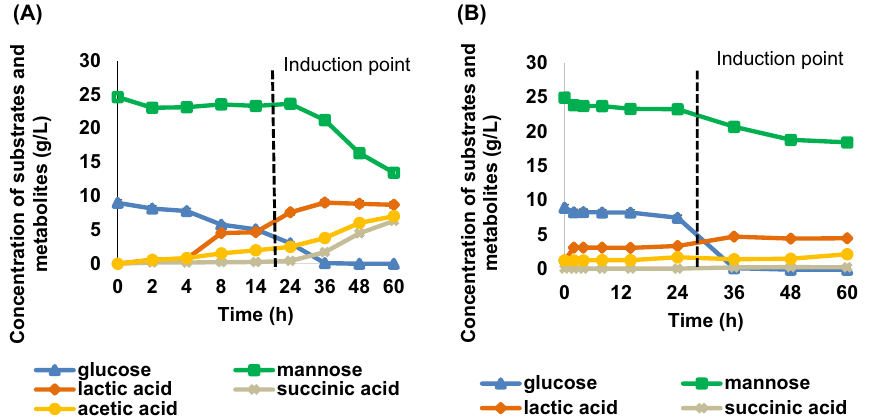
Figure 9. The time-course profile of batch fermentation of lactic acid production in ( A ) model hydrolysate and ( B ) PKC